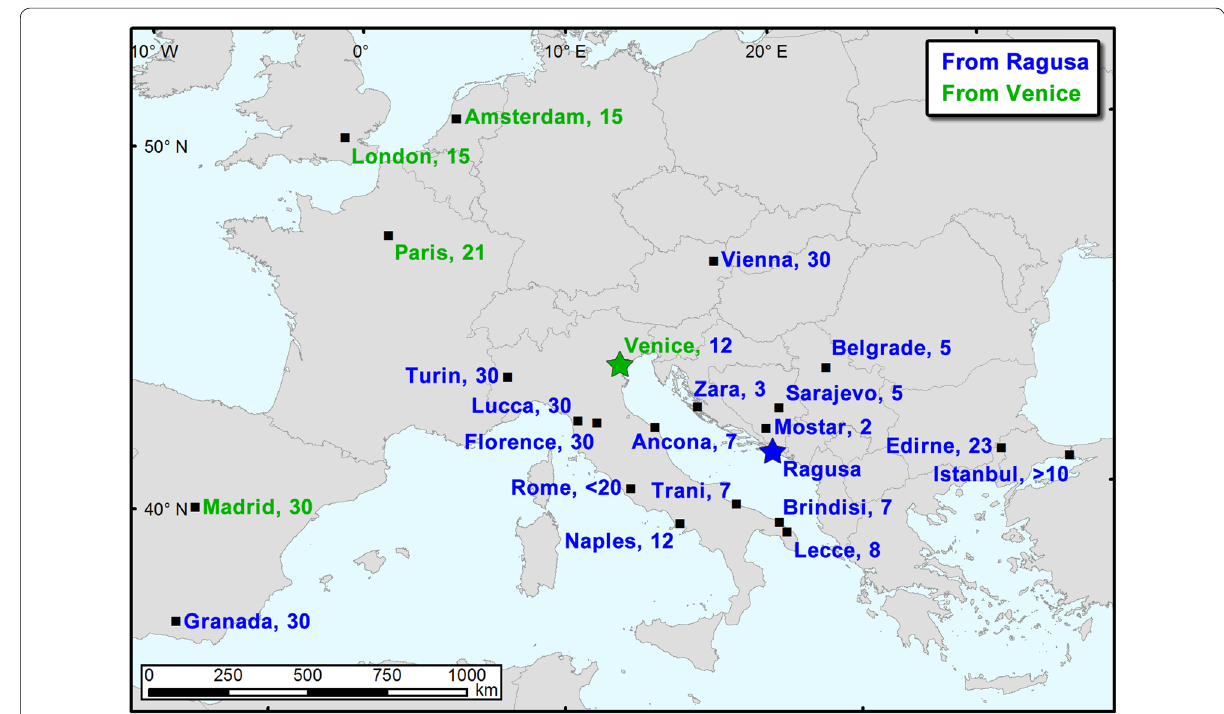
Fig. 4 Breaking news, from Ragusa and from Venice. From Albini (2015),